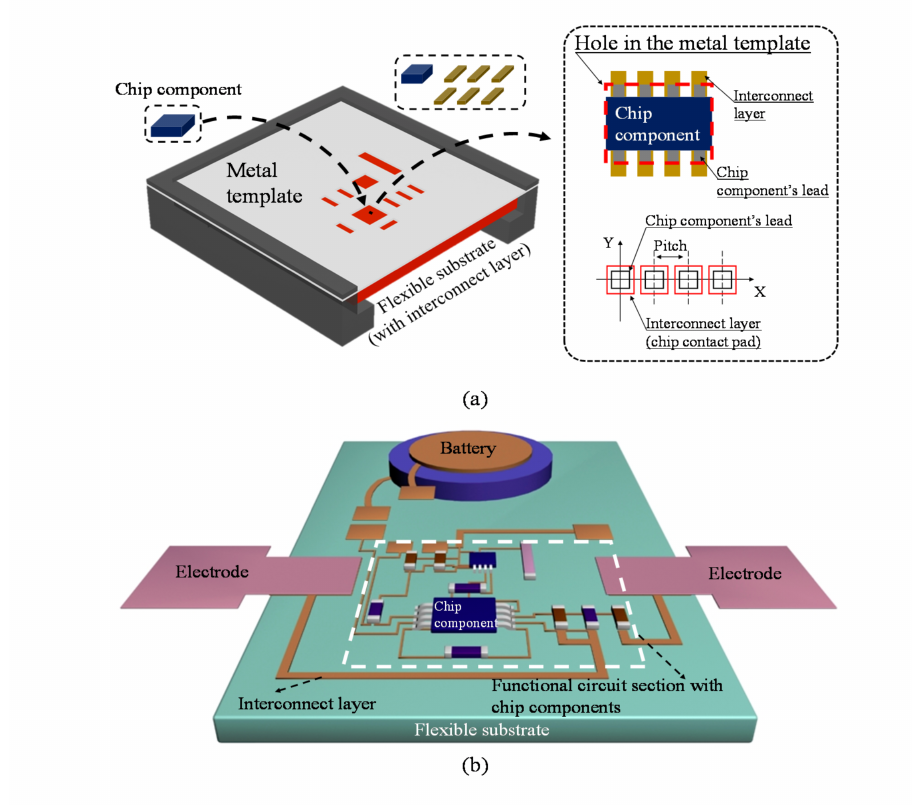
Figure 1. Schematic configurations of ( a ) passive alignment between chip components and an interconnect layer and ( b ) a flexible electronic sensor